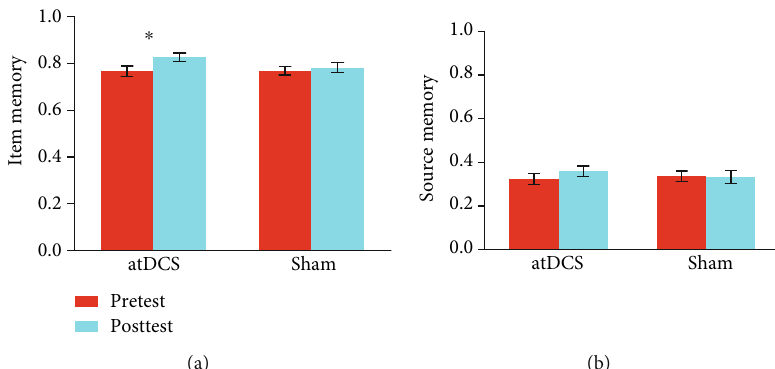
Figure 2: Item memory (a) and source memory (b) performance at pretest and posttest in the anodal transcranial direct current stimulation (atDCS) and sham groups. Error bars represent the standard error of the mean. ∗ p < 0 : 05 .